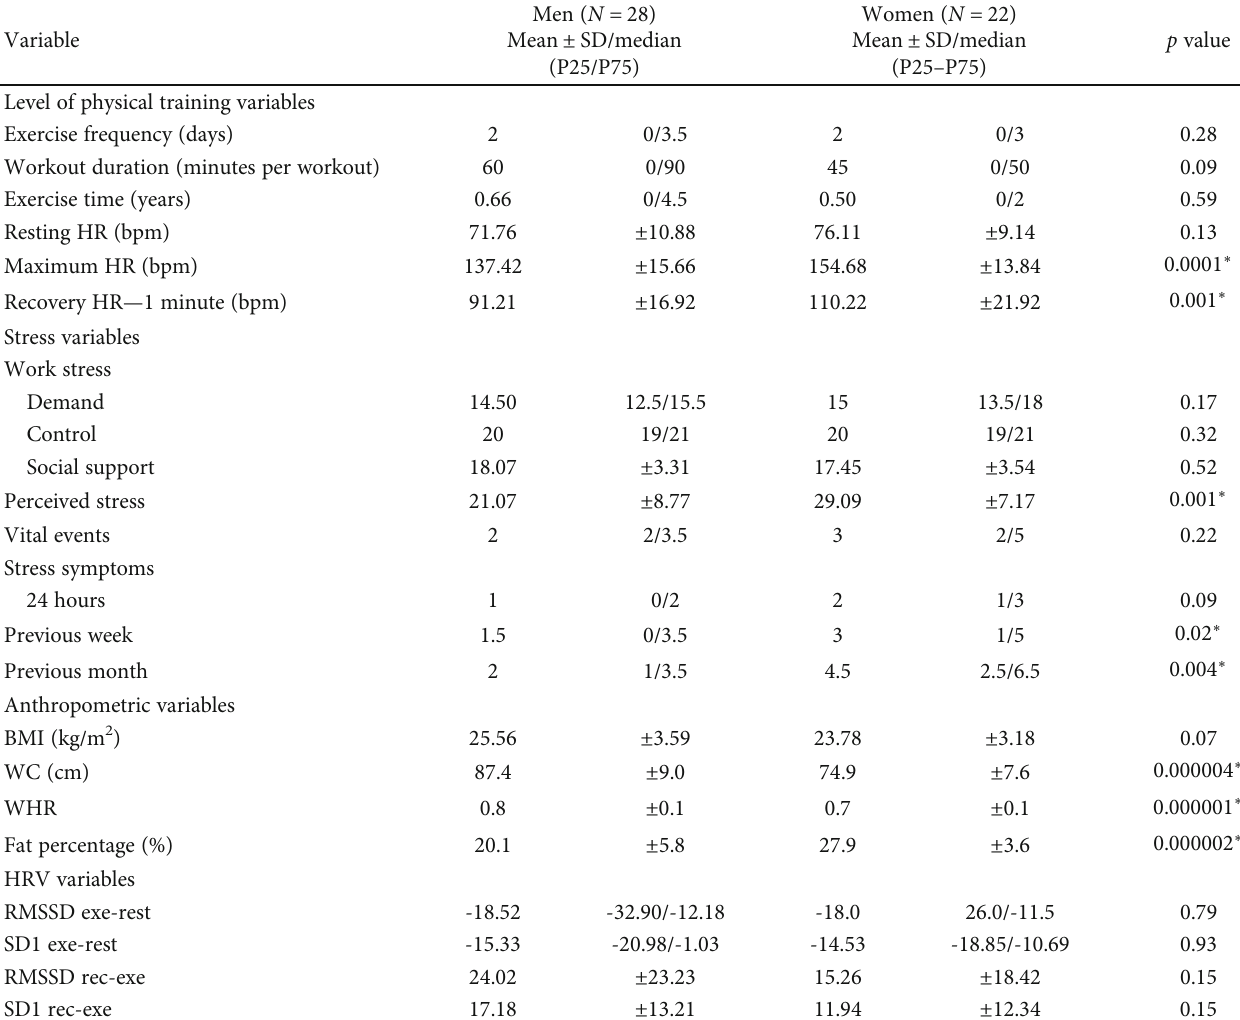
Table 1: Descriptive variables and di ff erences between men and